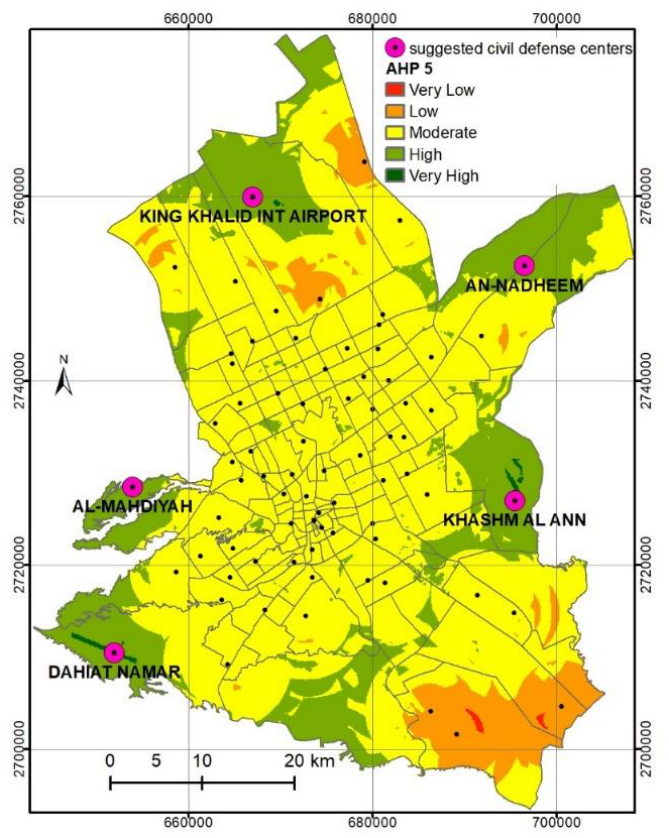
Figure 9. The best spatial distribution of the AHP-5 model overlain by the suggested new five CDCs. The highest correlation was found between layers C6 and C5, which represent the distance from commercial and educational centers, respectively (Tables 5 and 6). This pair of layers had similar influences on the determination of the validity of the existing and proposed new defense centers. This allowed us to reduce the weight used by neglecting one of these layers as they act as one layer. Thus, layer C5 can be neglected as it has a strong correlation with the other layers and will depend on layer C6 (Table 3). Similarly, the layers accident density (C2) and population density (C3) have a moderate correlation (Table 3). This is logical because accidents have a direct relationship with population density. Additionally, there is a moderate correlation between distance from educational services (C6) and distance from residential areas (C8; Table 3), which is also logical because educational services are close to residential areas. The PRC plots show that the AUC of all models increased after adding the five suggested CDCs, where AHP-1, AHP-2, and AHP-5 increased by ~0.68, 1.9, and 1.86, respectively (Figures 8 and 10). This work is in agreement with [22] that the AHP method is more robust than WSM in spite of the complexity of AHP. We agreed with [53,54,64–66] that the population density is the most effective criterion to determine the CDCs’